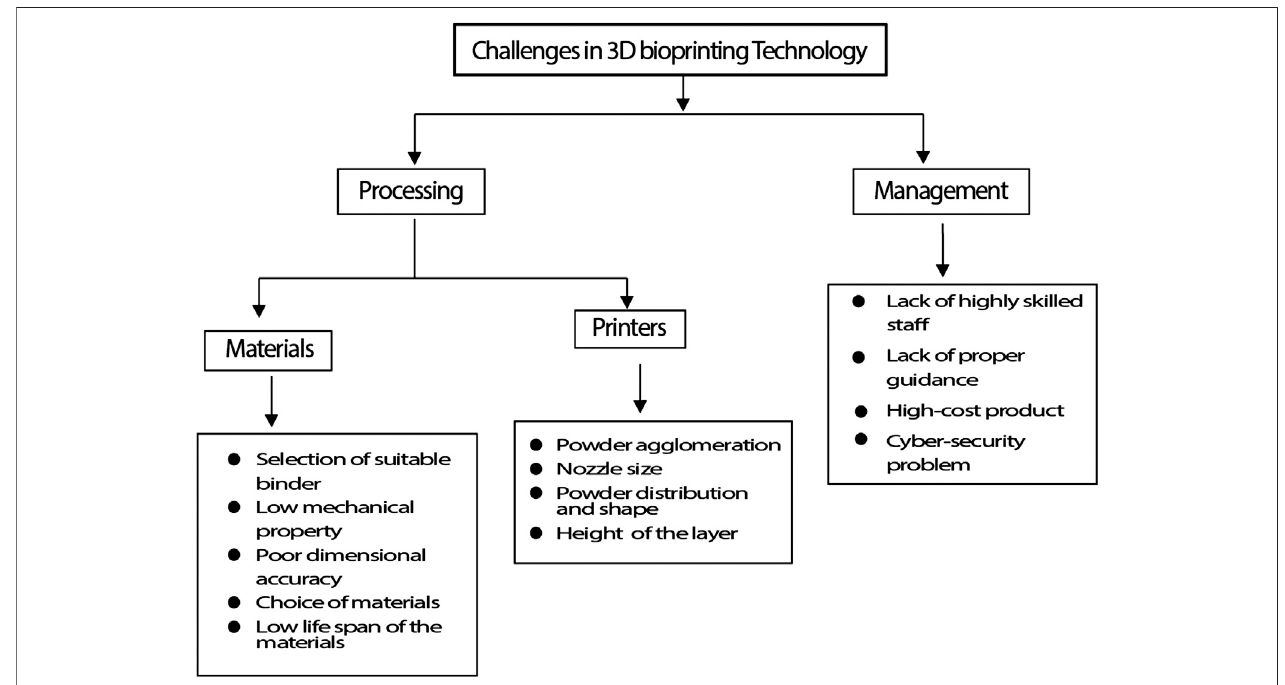
FIGURE 9 | Current challenges in 3D bioprinting techniques.